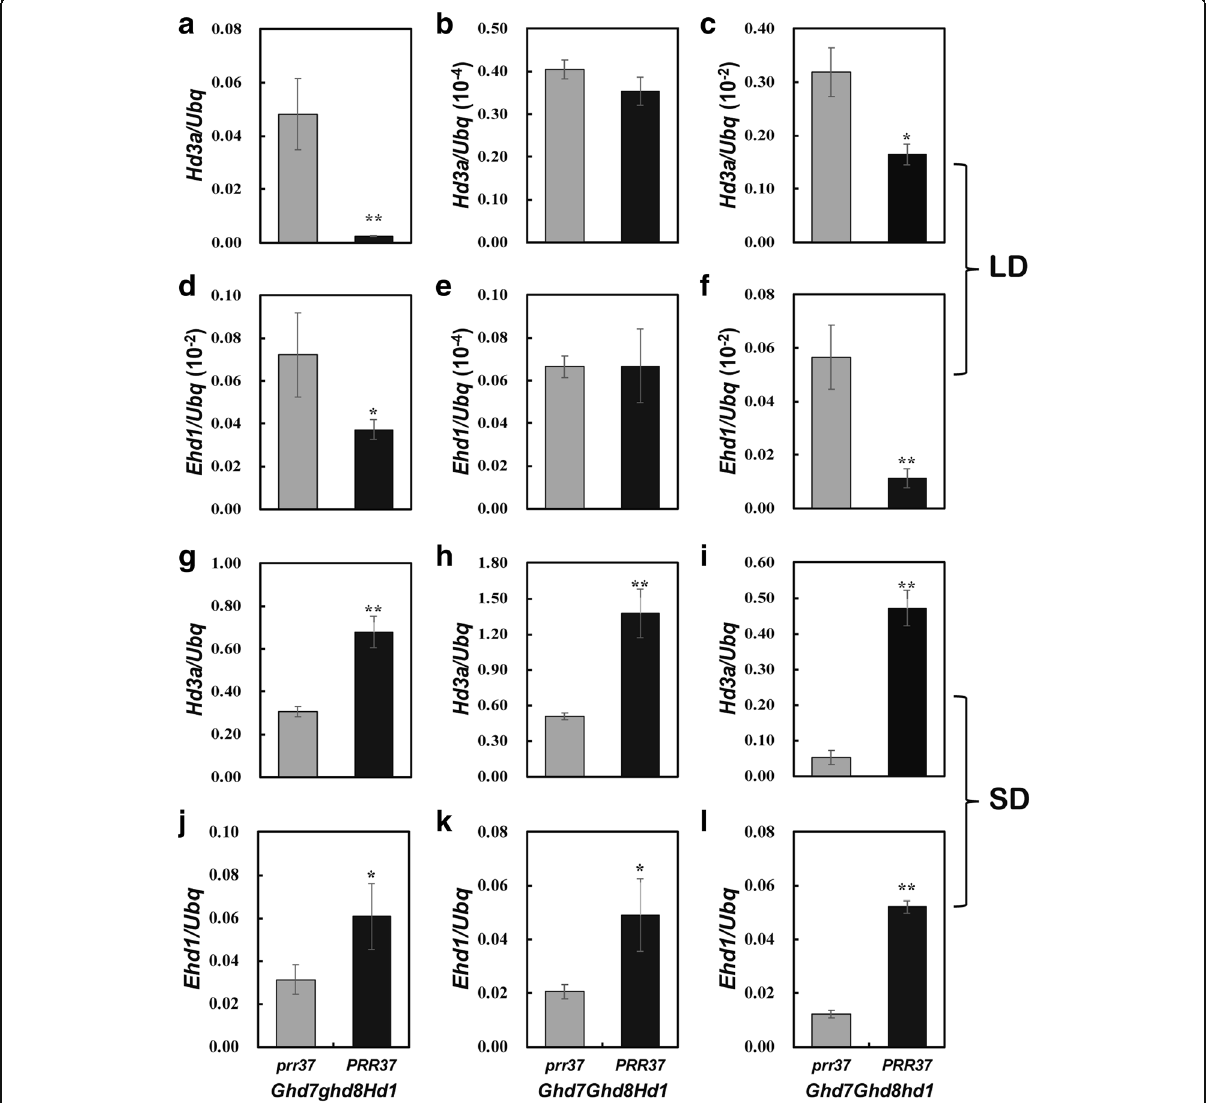
Fig. 4 Transcript levels of Hd3a and Ehd1 between prr37 and PRR37 under LD and SD conditions. Relative expression levels of Hd3a and Ehd1 between prr37 and PRR37 in the Ghd7ghd8Hd1 ( a , d ), Ghd7Ghd8Hd1 ( b , e ) and Ghd7Ghd8hd1 ( c , f ) backgrounds under LD conditions, respectively; Relative expression levels of Hd3a and Ehd1 between prr37 and PRR37 in the Ghd7ghd8Hd1 ( g , j ), Ghd7Ghd8Hd1 ( h , k ) and Ghd7Ghd8hd1 ( i , l ) backgrounds under SD conditions, respectively. * and **, P < 0.05 and P < 0.01 based on Student ’ s t -test,